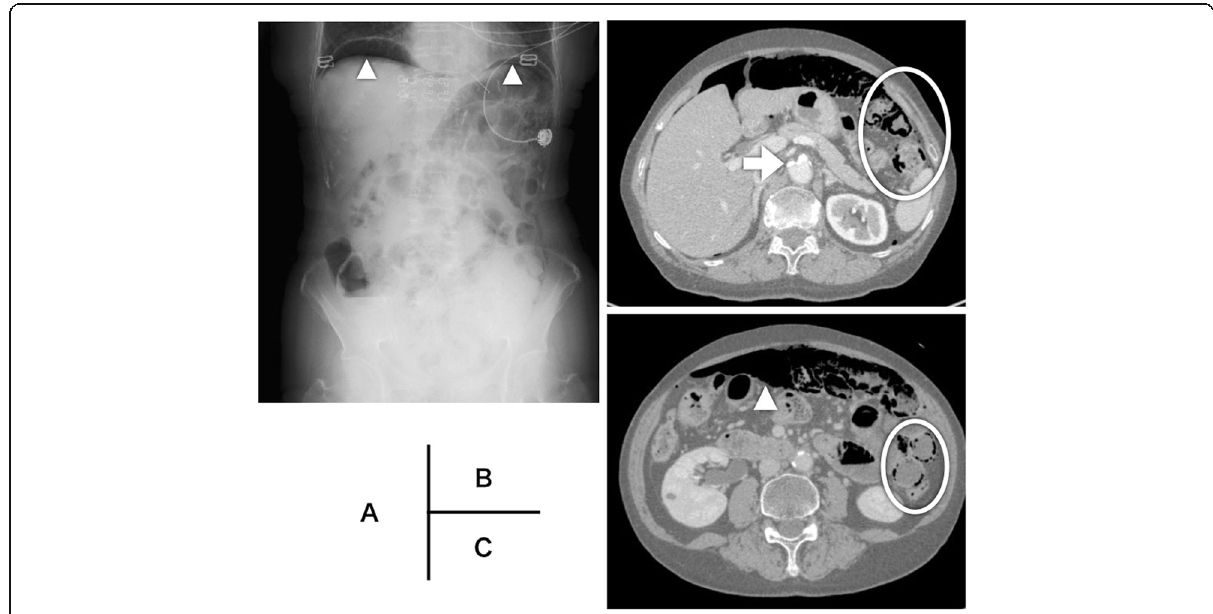
Fig. 1 Abdominal plain radiography showing free air ( a , triangle). Enhanced abdominal computed tomography showing severe calcification of the origin of the SMA (arrow), bubble-like intramural gas of the small bowel (circle), and pneumoperitoneum (triangle) ( b , c